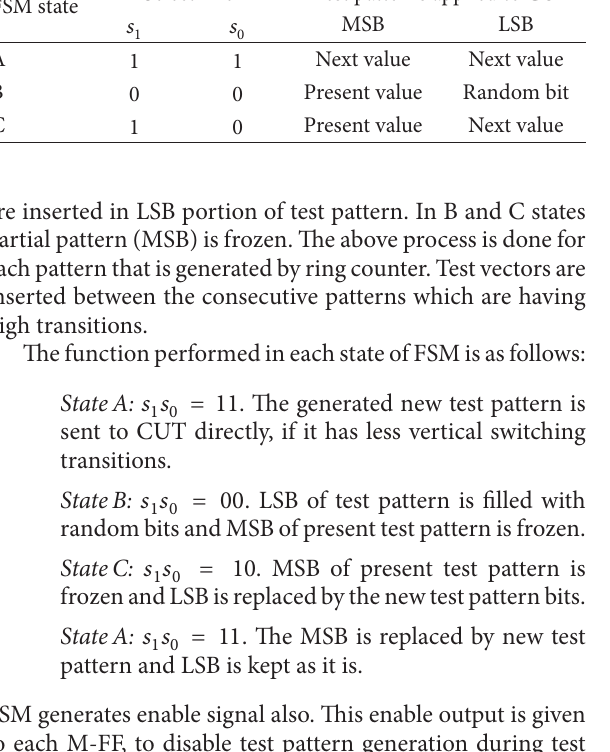
Table 2: Function performed at each FSM state. FSM